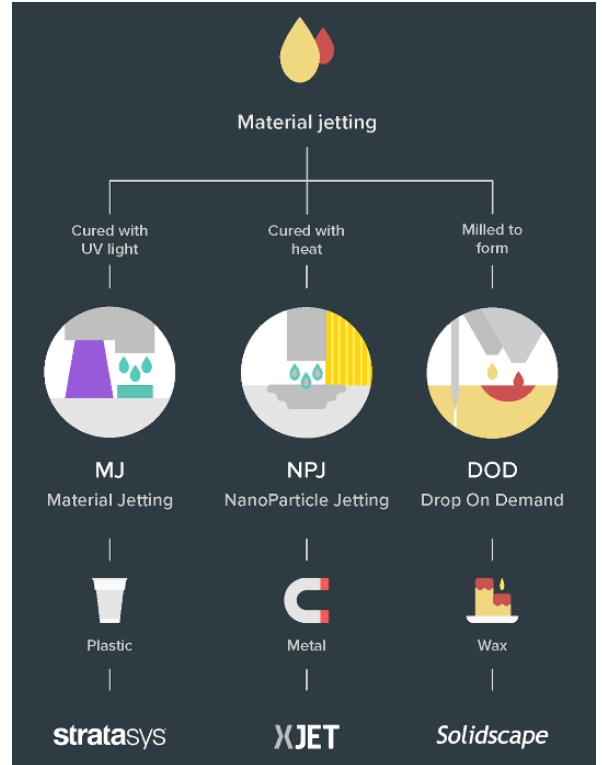
Figure 6. Material jetting technologies [67].